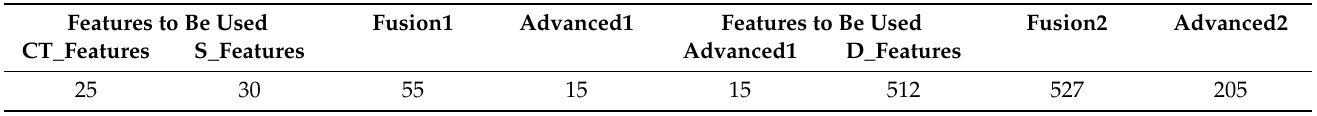
Table 3. The changes in feature dimensions during the two-stage multi-feature fusion process based on